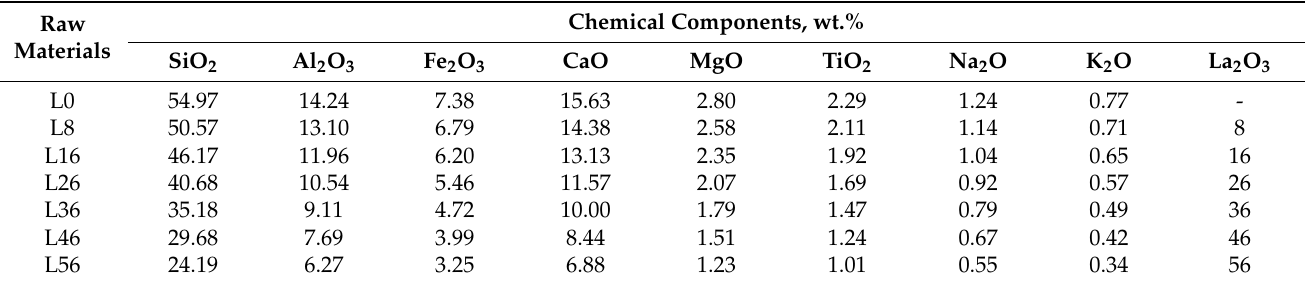
Table 1. Components of the basaltic glass from